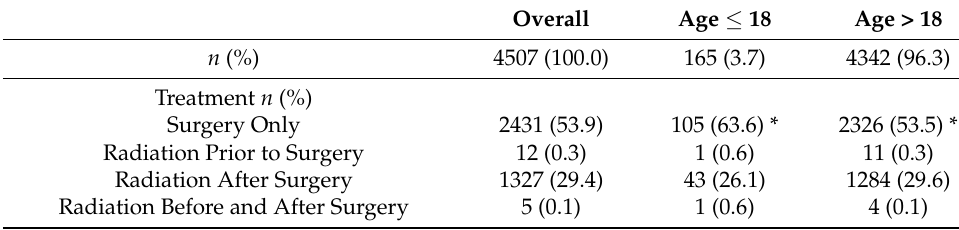
Table 3. Treatment modalities of 4507 Patients with Mucoepidermoid Carcinoma (MEC) from SEER Database (2000–2018) are first shown. This is divided into pediatric ( ≤ 18 years old) and adult groups (>18 years old). Survival length in years based on treatment type (surgery, radiation, combination of radiation and surgery in various orders, chemotherapy, surgery and chemotherapy, and combination of all 3 types). Chi-Square test analysis was performed to determine significant differences between age